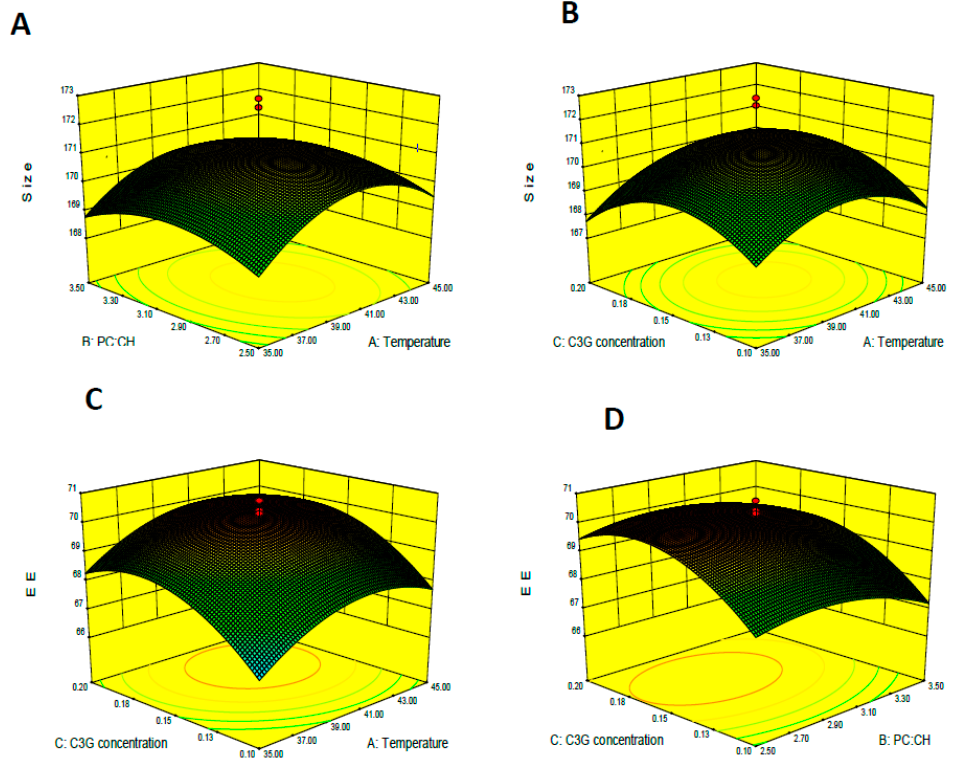
Figure 3. Response surface for the effects of independent variables on encapsulation efficiency and size of C3G nanoliposomes. The effects of phosphatidylcholine-to-cholesterol ratio and temperature on size are shown in ( A ) (C3G concentration = 0.15 mg/mL); The effects of C3G concentration and rotary evaporation temperature were shown in ( B ) (phosphatidylcholine-to-cholesterol ratio = 3);The effects of phosphatidylcholine-to-cholesterol ratio and temperature on EE (%) are shown in ( C ) (phosphatidylcholine-to-cholesterol ratio = 3); The effects of phosphatidylcholine-to-cholesterol ratio and C3G concentration were shown in ( D ) (rotary evaporation temperature = 40 °C).